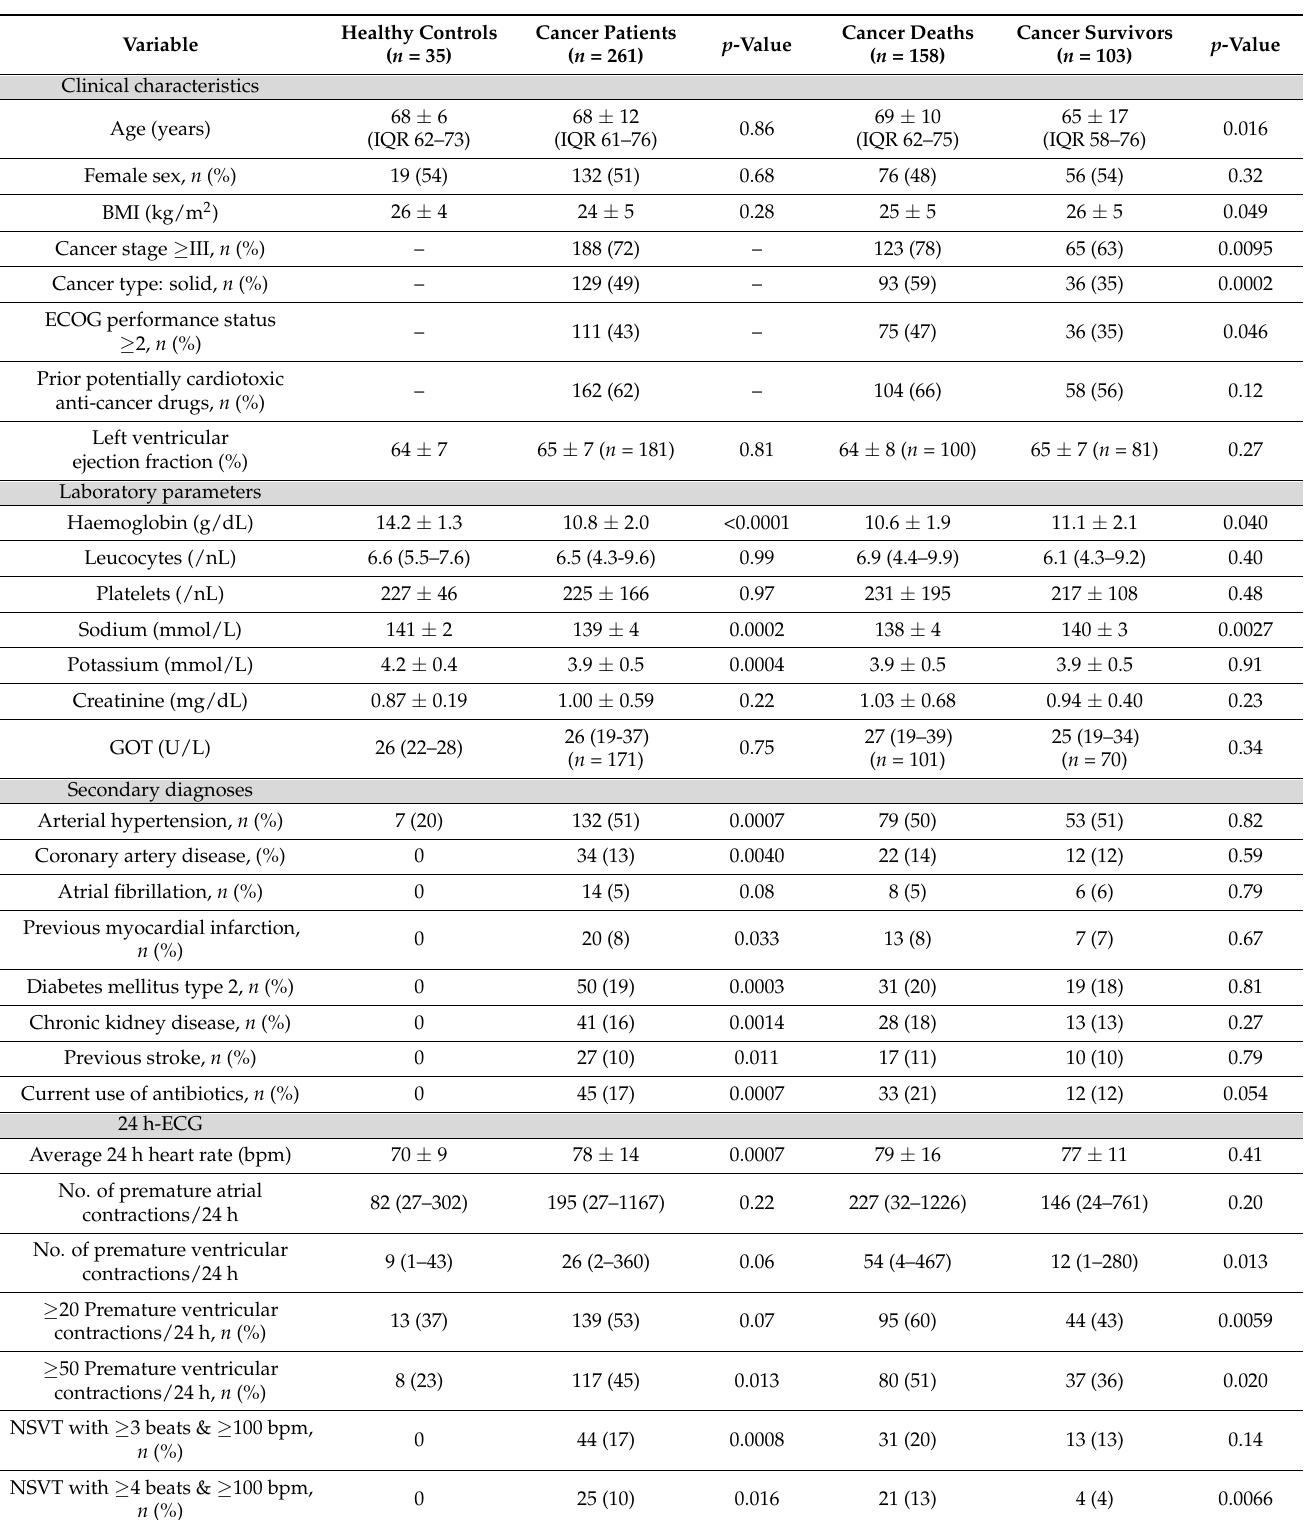
Table 1. Baseline